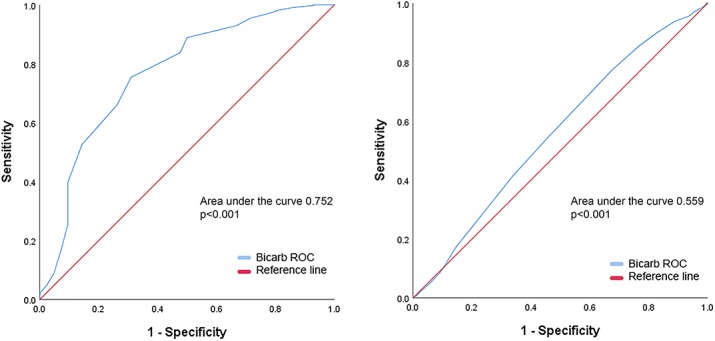
Kaplan Meier curves of the relationship between overall survival and serum bicarbonate levels (Left) Kaplan Meier curve of 30-day mortality in patients with normal, low and high serum bicarbonate (Right) Kaplan Meier curve of 5-year overall survival in patients with normal, low and high serum bicarbonate.